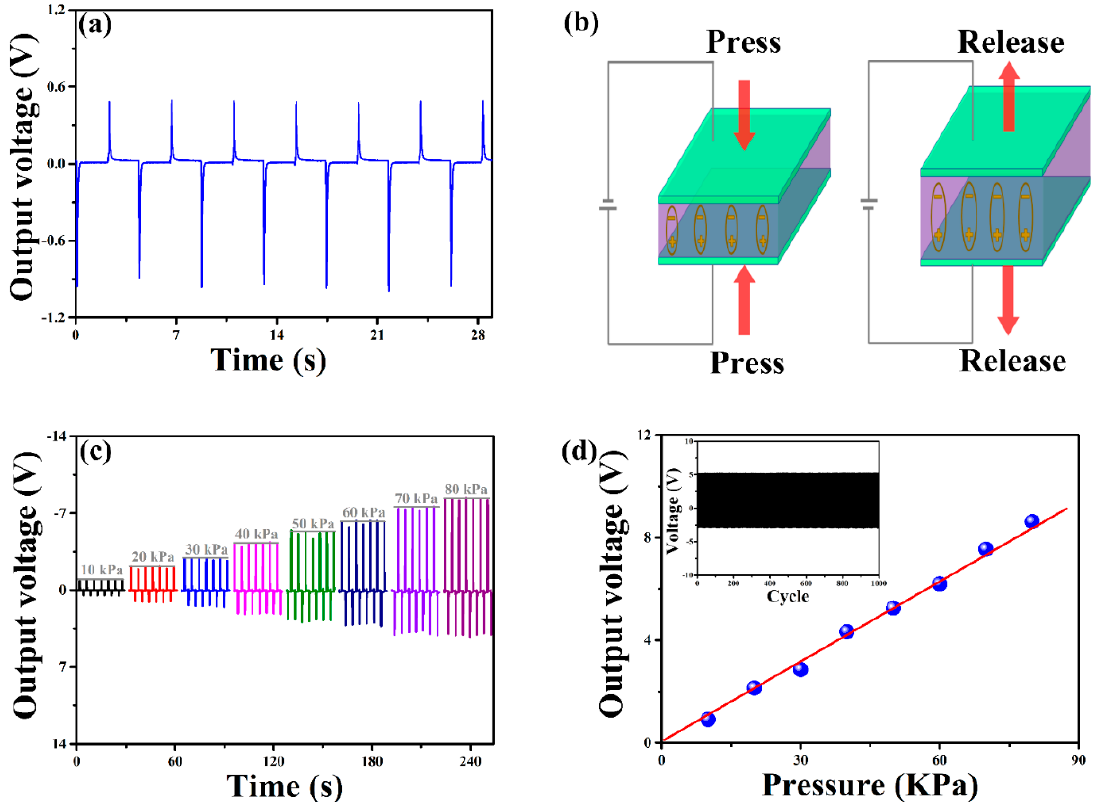
Figure 4. ( a ) Piezoelectric output voltage on BST at the applied periodic pressure of 10 kPa. ( b ) Schematic illustration of the piezoelectric effect of sandwiched BST between two electrodes. ( c ) Stress-triggered output voltage in the range of 10 kPa and 80 kPa. ( d ) Linear relationship between the performed pressure and the output voltage. The inset indicates the long-term operation stability of this device under the applied pressure of 50 kPa.